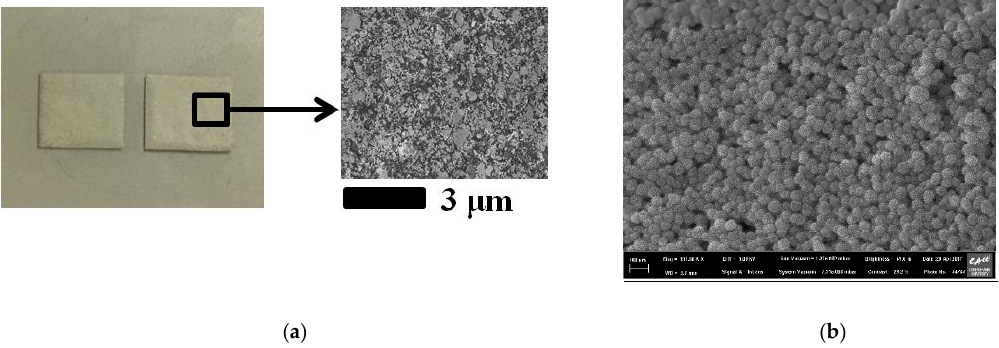
Figure 7. ( a ) Pictures of the screen-printed Ag pattern with drop spacing of 3 μm; ( b ) FE-SEM picture with a drop spacing of 100 nm.